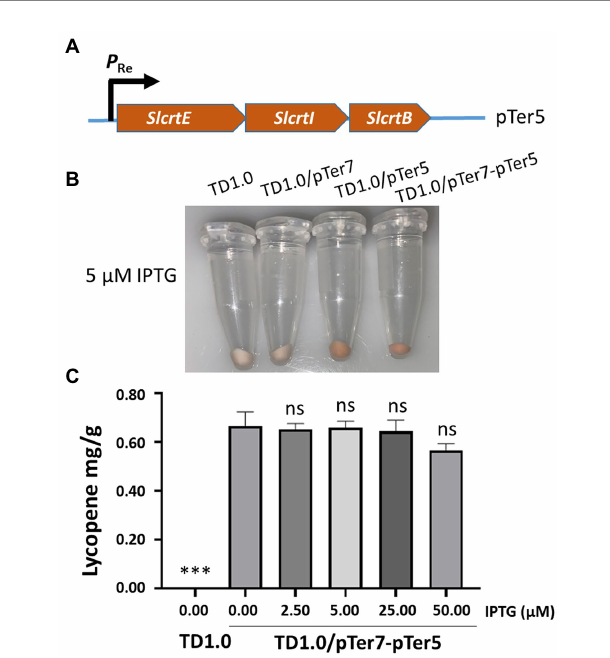
FIGURE 3 Change in downstream module genes to enhance the production of lycopene. (A) Schematic diagram of the construction of the pTer5 plasmid carrying MVA pathway downstream genes derived from S. lividans . (B) Cells were grown in a minimal medium supplemented with 30 g/L glucose as carbon source. Cell pellets of H. bluephagenesis strains TD1.0, TD1.0/pTer7, TD1.0/pTer5, and TD1.0/pTer7-pTer5 after induction with 5.00 μ M of IPTG. (C) Lycopene production in TD1.0/ pTer7-pTer5 after induction with the specified IPTG concentrations. The experiments were repeated three times for each concentration of IPTG induction. Cells were grown in a minimal medium supplemented with 30 g/L glucose as carbon source. All samples were obtained after 48 h cultivation at 37 ° C with shaking. The lycopene yield was calculated using the standard curve and presented as mg per gram of dried cell weight (DCW). The data were presented as mean ± SD. Statistical significance was calculated by One-way ANOVA and compared to TD1.0/pTer7-pTer5 without IPTG induction; ns indicates no statistical significance, *** p <